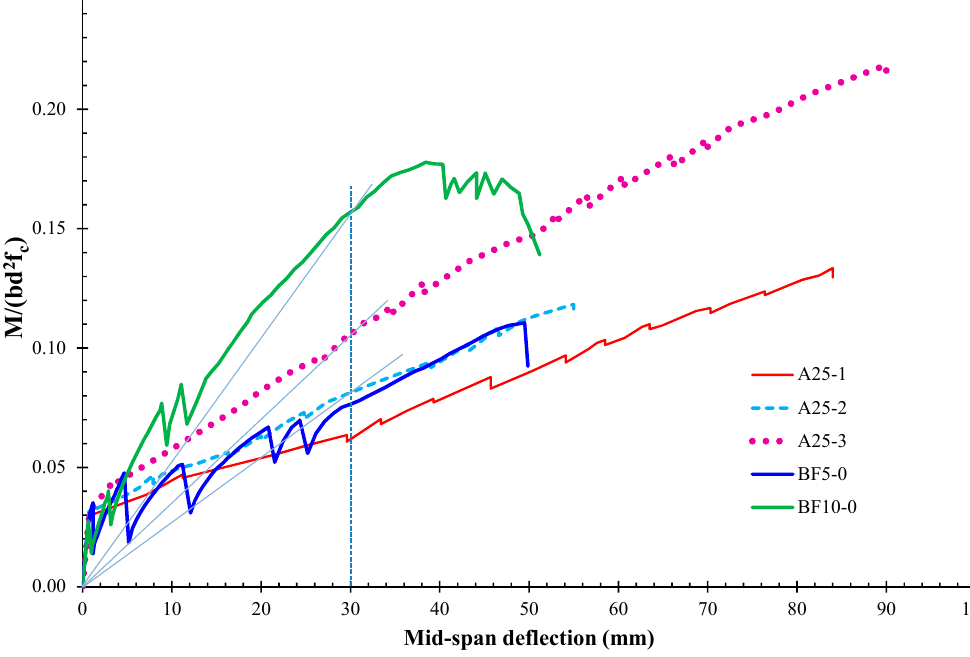
Figure 10. Comparison of test results for C-FRP reinforced beams BF5-0 and BF10-0 (present study) with beams reinforced with G-FRP bars (beams A25-1, A25-2, A25-3 from literature [40]).